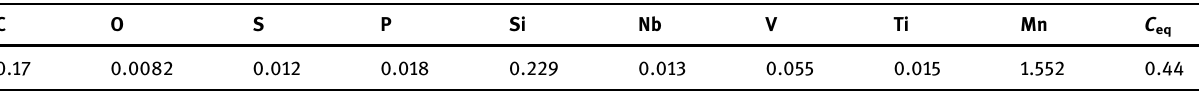
Table 2: Chemical composition of the experimental rebar ( mass fraction, % )